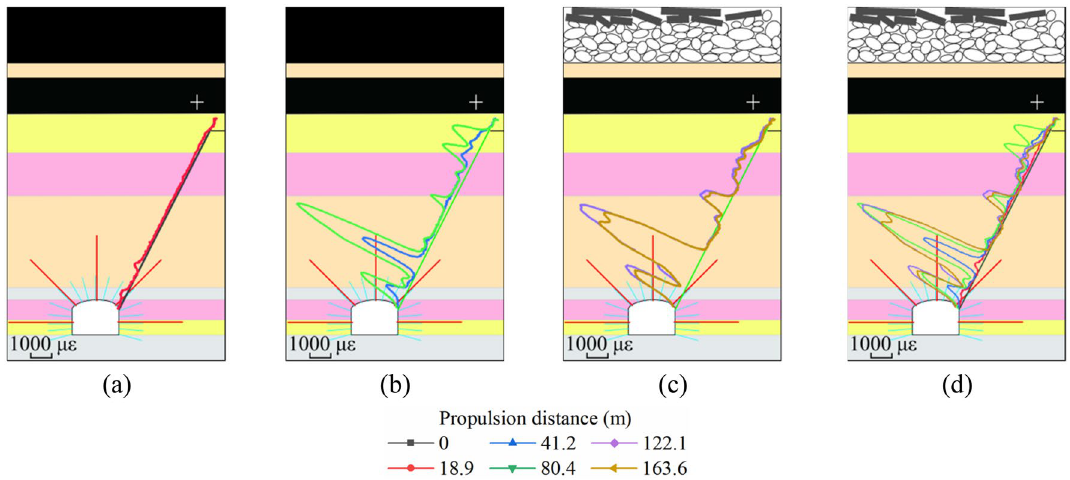
Figure 14. Correspondence between optical fiber strain data curve and surrounding strata of